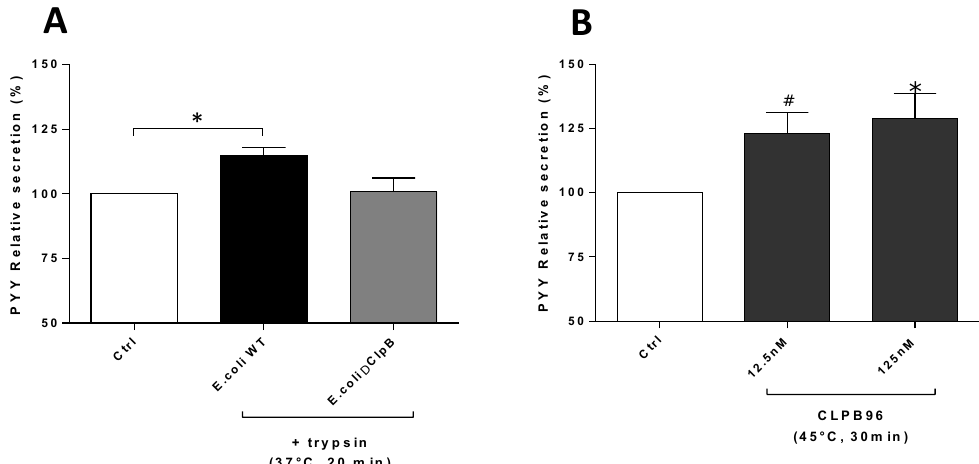
Figure 1. Effects of fragmentation of E. coli WT, E. coli ∆ CLPB proteins, and CLPB96 on PYY secretion. PYY relative secretion (ng/ µ L) was measured ( A ) after incubation of total proteins of E. coli WT